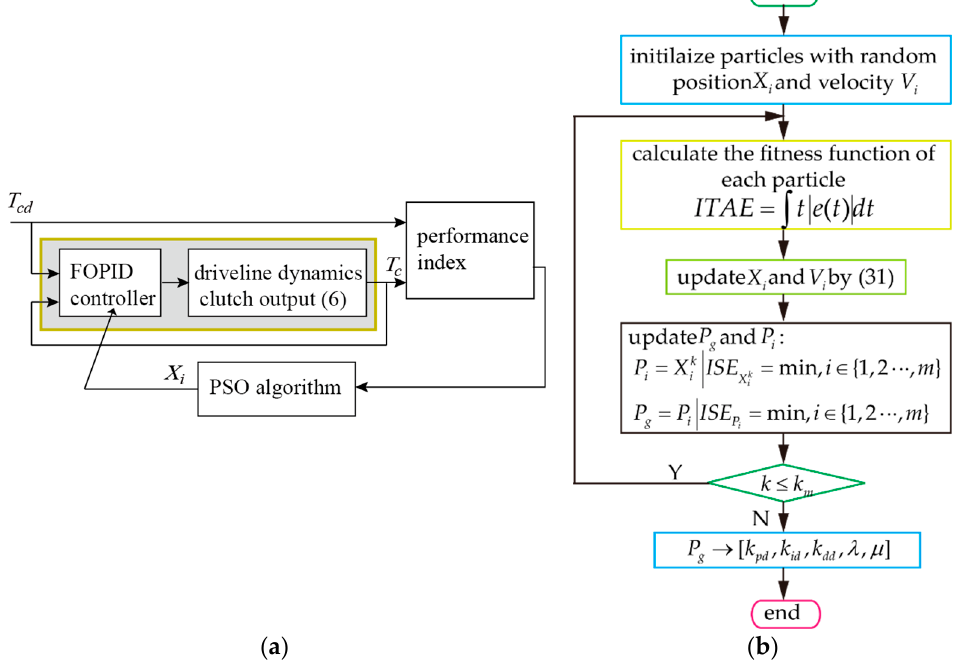
Figure 6. Schematic diagram of the particle swarm optimization (PSO) algorithm. ( a ) Schematic diagram of the parameter optimization offline, ( b ) flowchart of PSO.